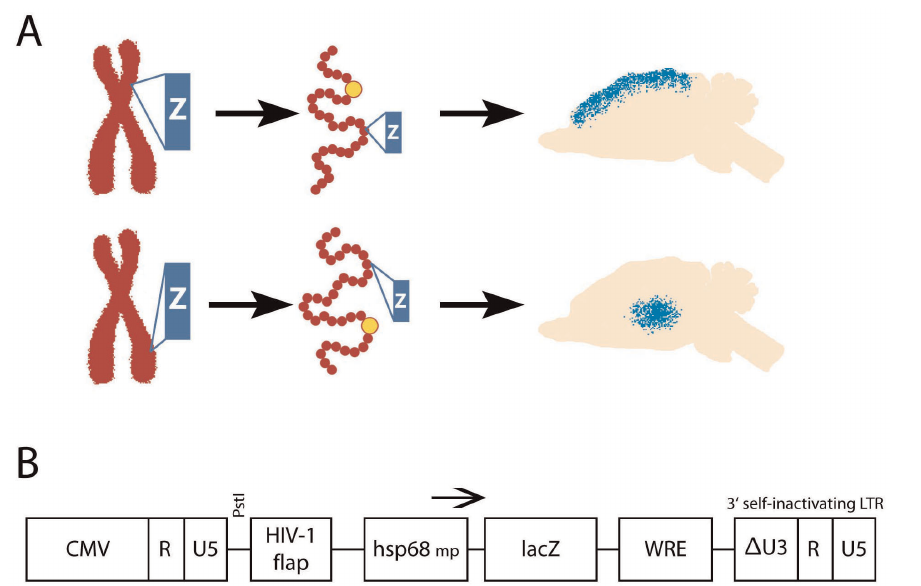
Figure 1. Generation of transgenic mice carrying a nlacZ enhancer probe under control of a hsp68 minimal promoter. Enhancer probes integrate into different sites in the genome. Depending on the site of integration the interaction of the introduced minimal promoter and enhancer elements of the genome results in restricted expression of the transgene.